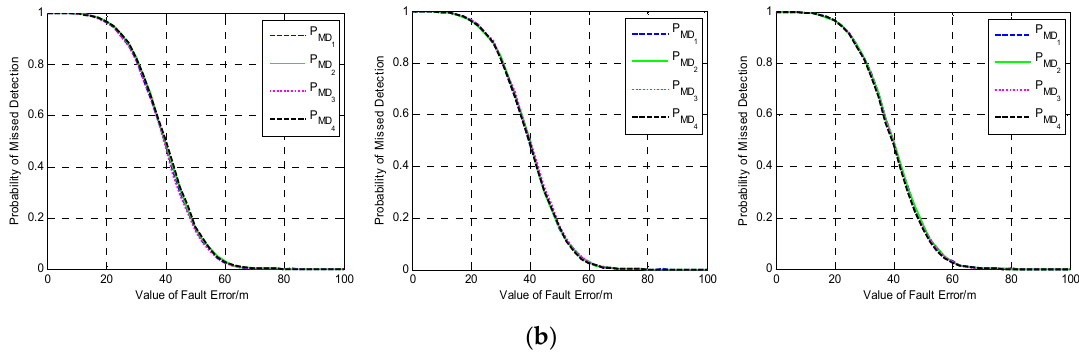
Figure 1. The fault detection results under three different geometries of four visible satellites. ( a ) Sky plot views of the satellite geometries; ( b ) The probabilities of missed detection under different alternative hypotheses as a function of fault error.